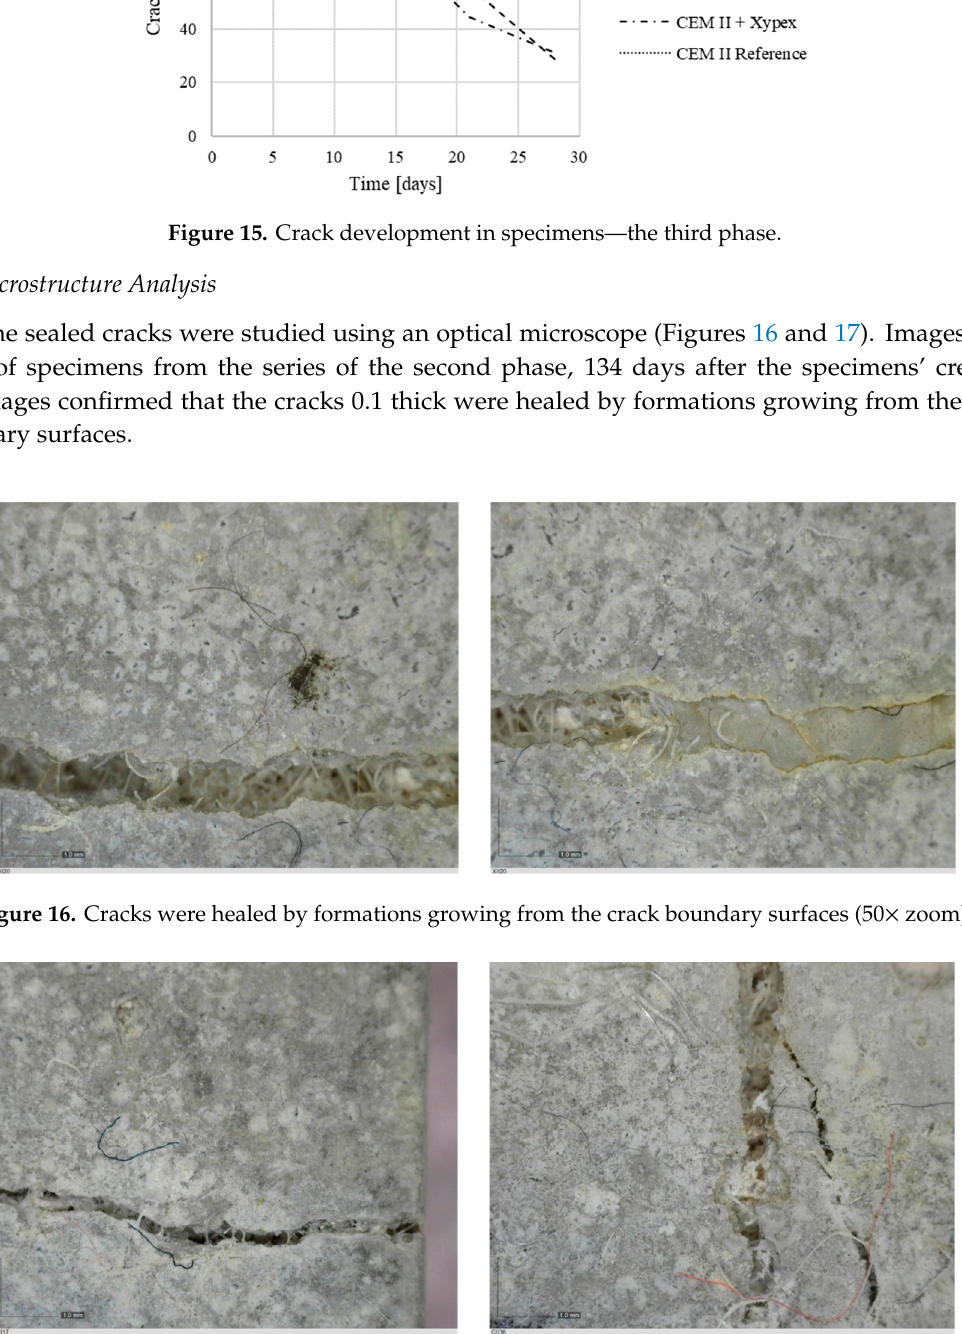
Figure 17. Cracks were healed by formations growing from the crack boundary surfaces (50× zoom).